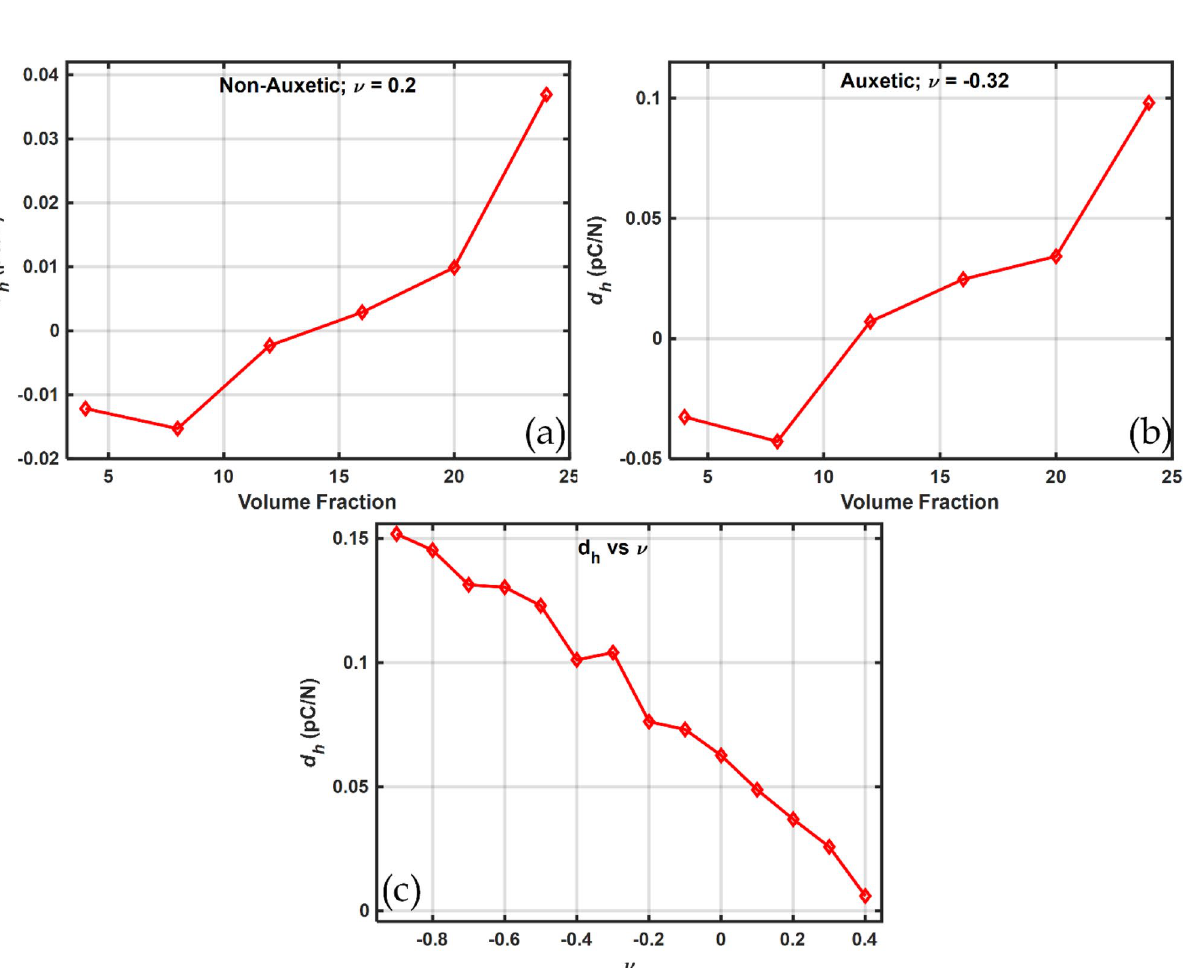
Figure 17. Hydrostatic charge coefficient d h calculated for ( a ) Non-Auxetic, ( b ) Auxetic piezocomposite and, ( c ) in the Poisson’s ratio range of −0.9 to